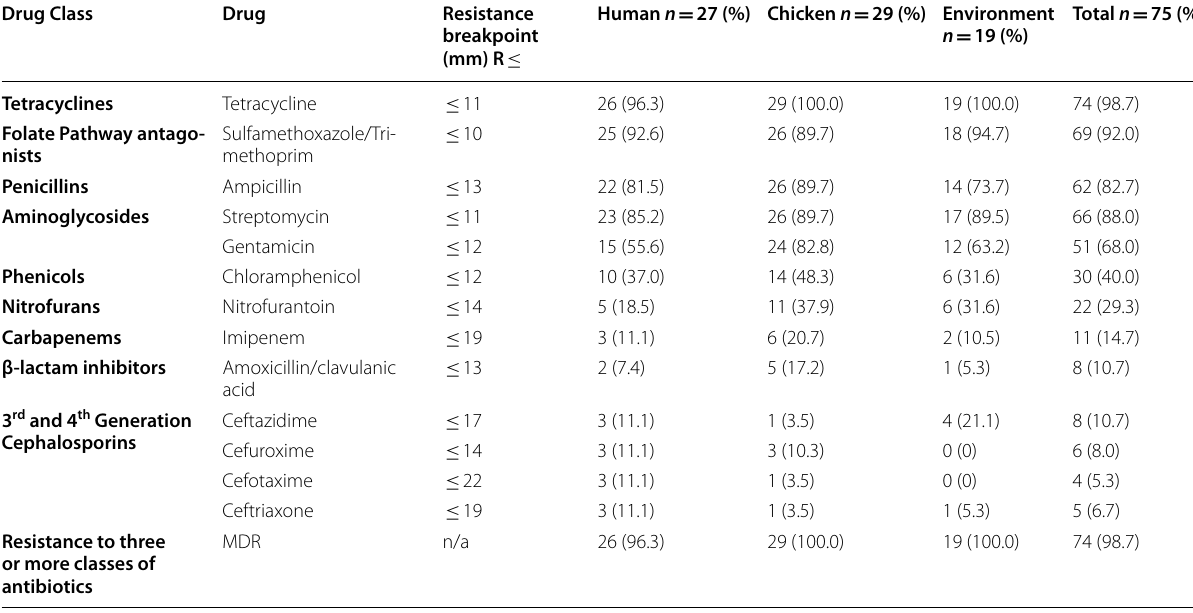
Table 2 Antimicrobial resistance profiles of 75 quinolone-resistant Escherichia coli isolates from humans, chickens, and poultry farm/ market environments using the disk diffusion